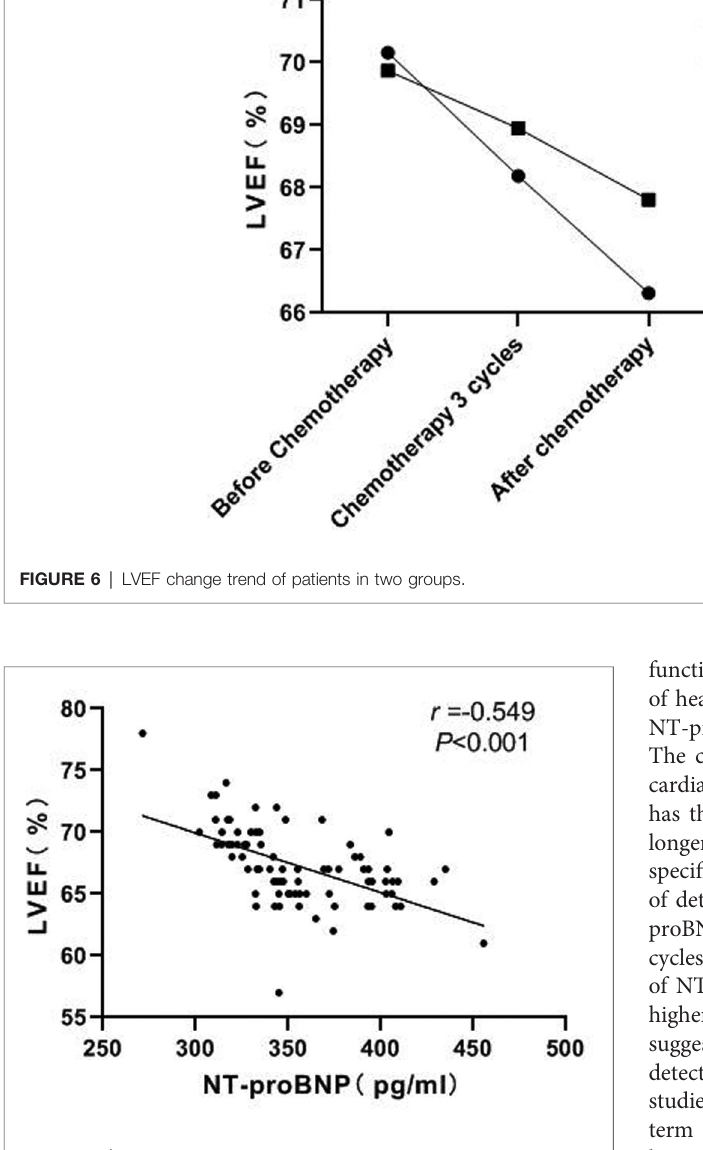
FIGURE 7 | Correlation between NT-proBNP and